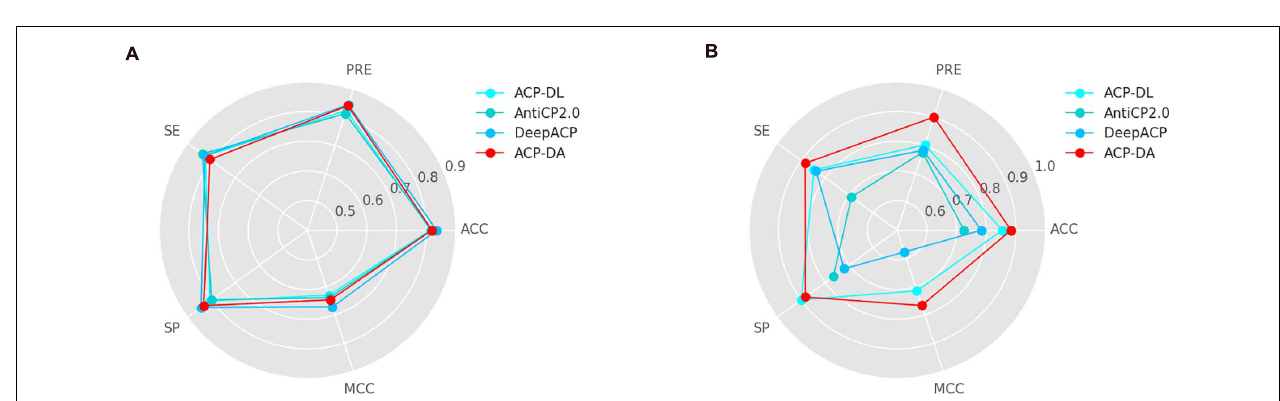
FIGURE 4 | Comparison of the prediction models with and without data augmentation based on (A) ACP740 and (B) ACP240.